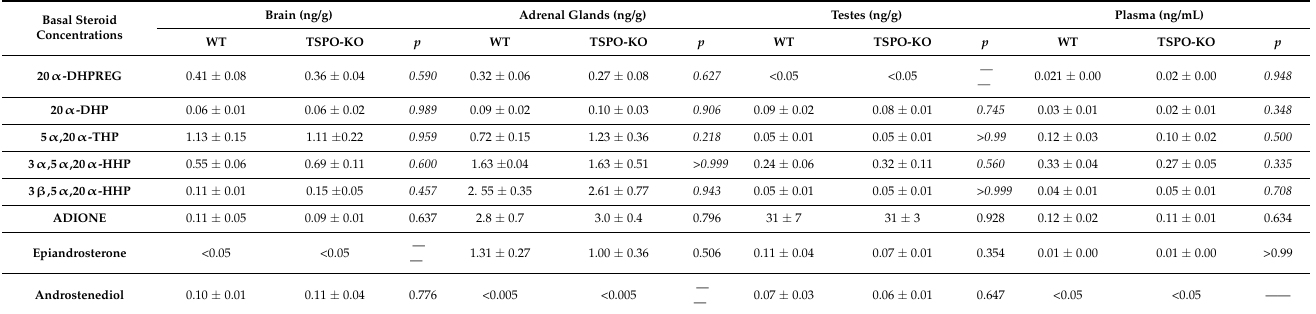
Table 1. Basal concentrations of 20 α -reduced steroids, ADIONE, epiandrosterone and androstenediol in tissues of male WT and TSPO-KO mice ( n =